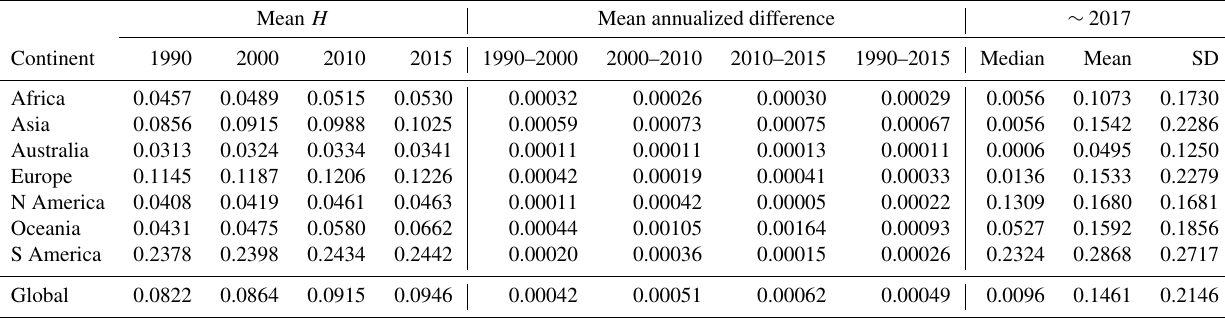
Table 4. Summary of estimates of the degree of human modification ( H ) and the mean annualized difference between 5- or 10-year incre- ments for which change over time can be calculated (1990, 2000, 2010, and 2015) and H values for the contemporary dataset ( ∼ 2017, all stressors). Mean annualized mean difference is calculated as the mean value across the continents of the difference in H values divided by the number of years (e.g., H mad = ( H 2015 − H 1990 ) / 25).